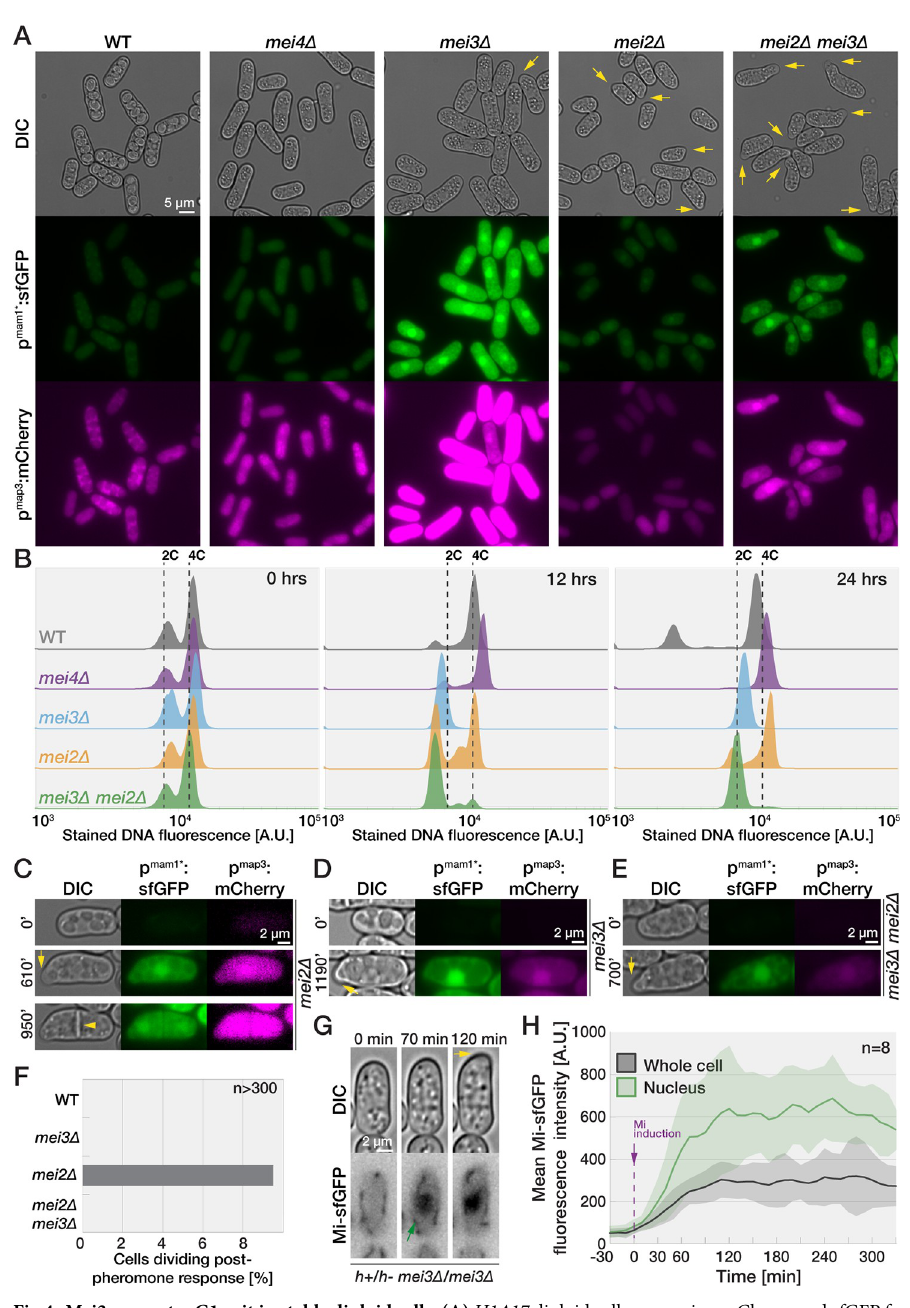
Fig 4. Mei3 promotes G1 exit in stable diploid cells. (A) H1 Δ 17 diploid cells expressing mCherry and sfGFP from P- and M-cell-specific promoters p map3 and p mam1 24 hours after removal of nitrogen. Arrows point to shmoo-like projections in mei3 Δ and mei2 Δ mutants. (B) Flow cytometry analysis of Hoechst-stained DNA fluorescence (x-axis) in diploid cell used in (A) at indicated time points after nitrogen removal. The y-axis shows the cell number normalized to mode. Note that mei3 Δ and mei3 Δ mei2 Δ mutants arrest with unreplicated genomes (2C), while wild- type, mei4 Δ , and mei2 Δ cells replicate their DNA (4C). The sub-2C population in wild-type sample are likely spores. (C–E) Time lapses show induction of fluorophores in cells as in (A). Note formation of mating projections (arrows) and the septum in mei2 Δ mutant (arrowhead). (F) Percentage of H1 Δ 17 diploids expressing both p mam1 :GFP and p map3 :mCherry that are septating. (G and H) Time lapse (G) and quantification (H) of Mi-sfGFP induction in H1 Δ 17 diploid cells deleted for mei3 . Note that Mi-sfGFP induction (black line in H) coincides with its nuclear accumulation (green arrow in G and green line in H) and precedes the formation of the shmoo (yellow arrow in G). The graph reports mean fluorescence for 8 cells with shaded areas denoting standard deviation. The data underlying this Figure may be found at